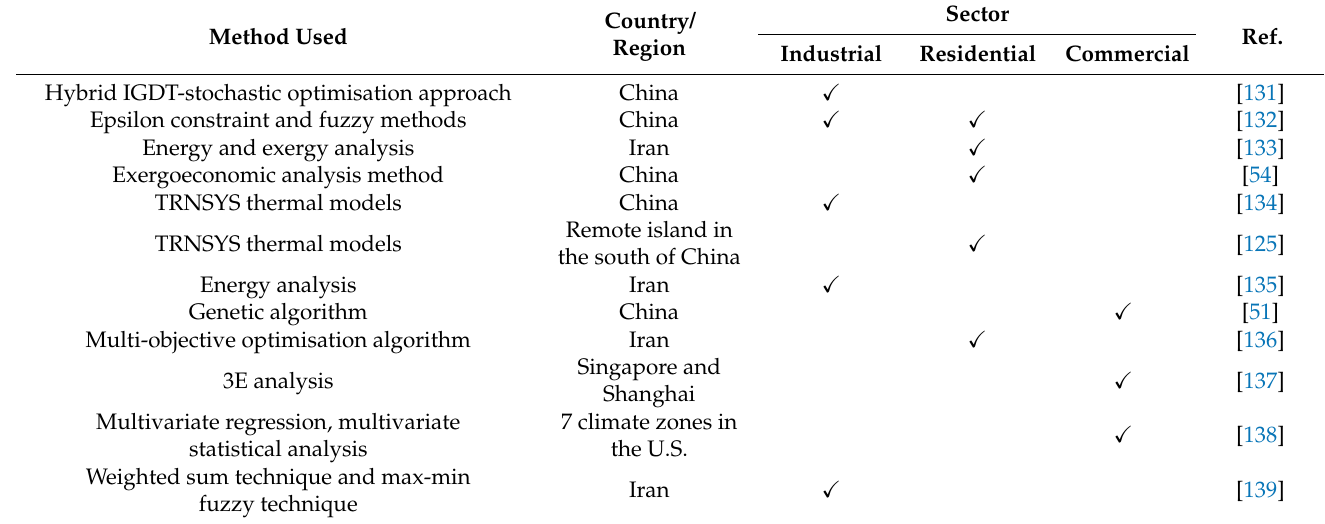
Table 6. Methods, demographic, and sector details of studies related to environmental aspects of CCHP